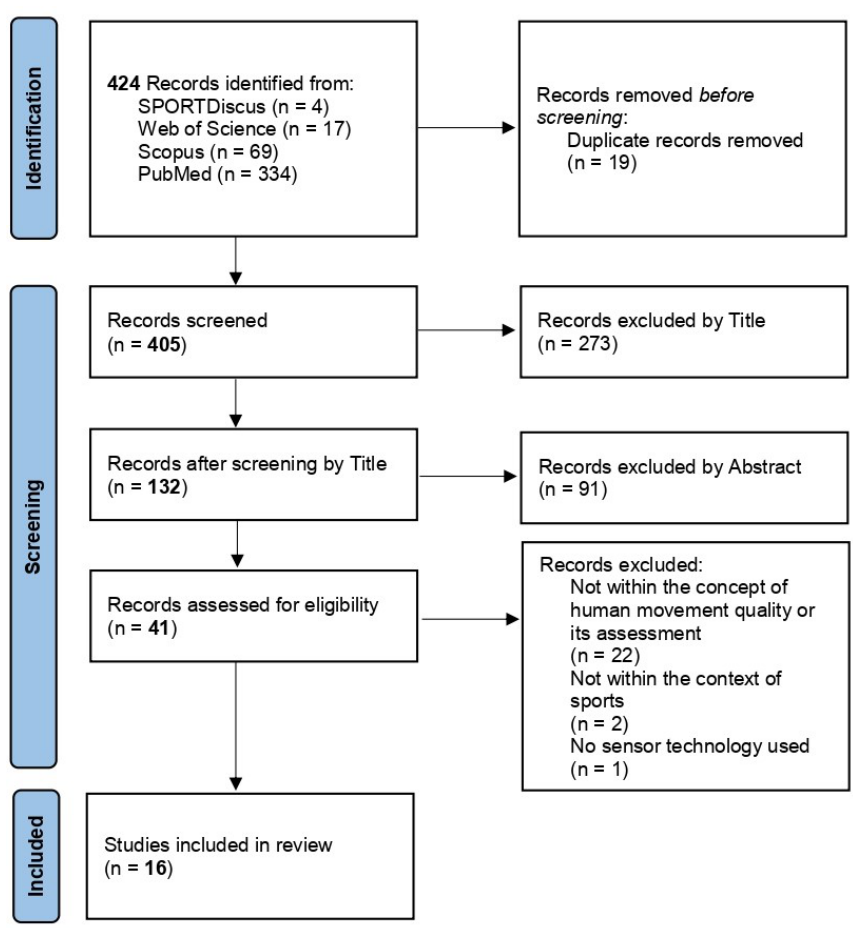
Figure 2. PRISMA flow